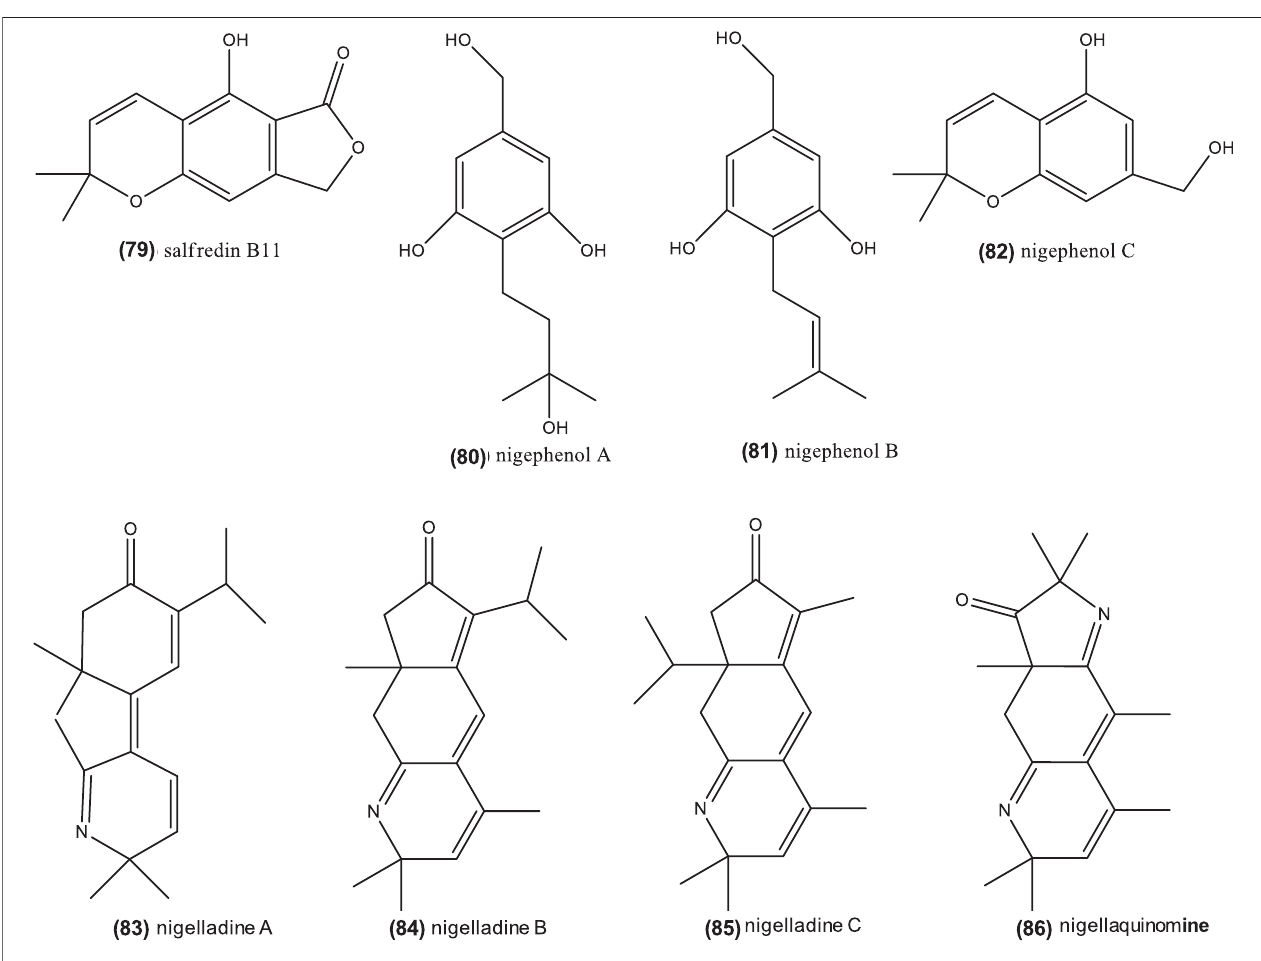
FIGURE 6 | Chemical structure of salfredin B11, nigephenol A-C and of nigelladine A – C and nigellaquinomine.